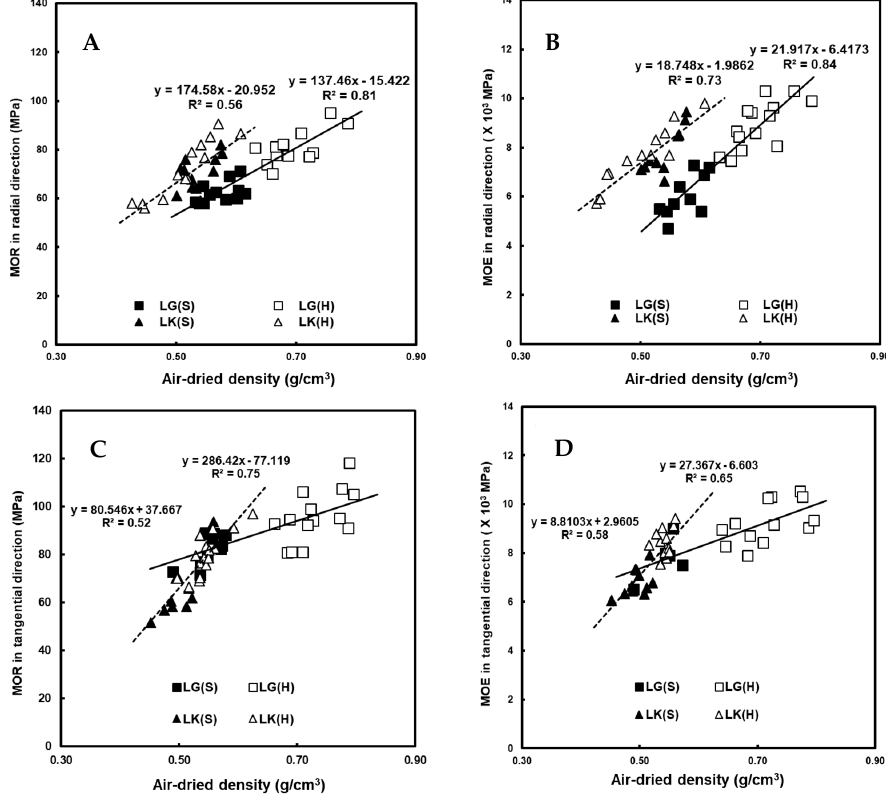
Figure 3. Relationship between air-dry density and bending properties in the radial ( A , B ) and tangential directions ( C , D ) of the sample species. LG: Larix gmelinii ; LK: Larix kaempferi ; S: Sapwood; H: Heartwood. Table 5. Pearson’s correlation coefficient between bending and physical properties